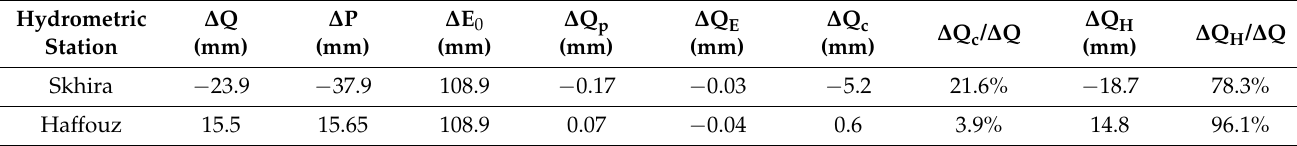
Table 6. Annual average hydrological variables and climate elasticity for the different periods of the Merguellil watershed. Hydrometric